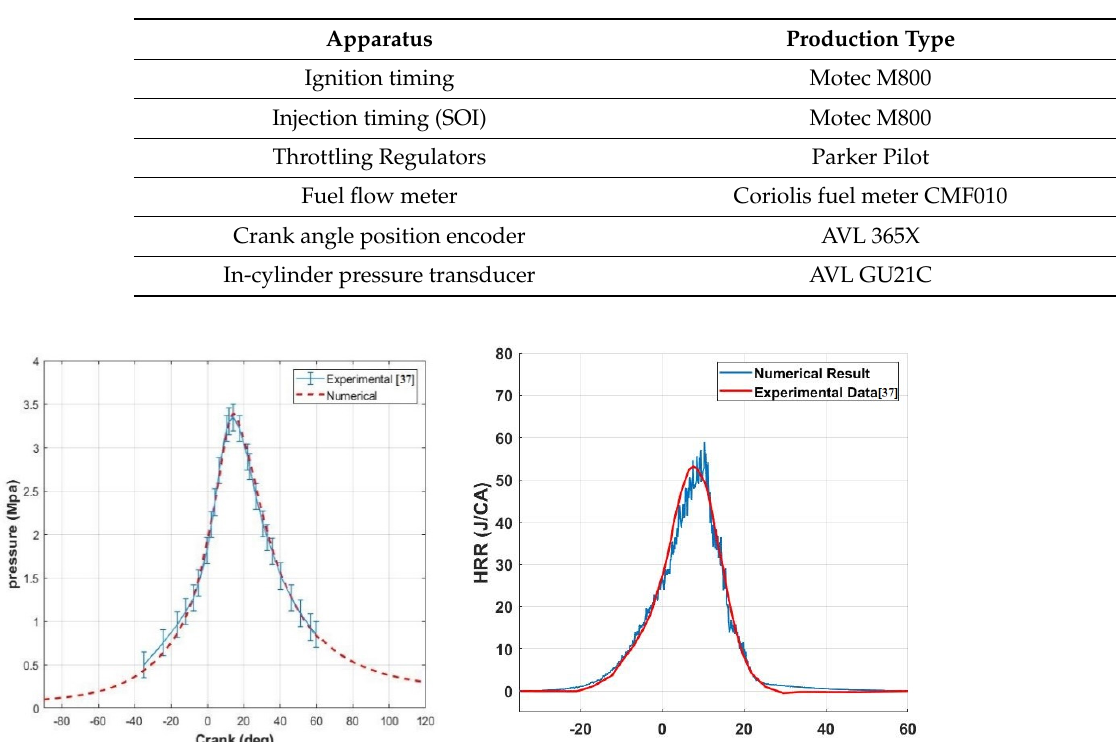
Table 5. Instrumentation apparatus for measurement. Reproduced with permission from Aghahasani, M., etc., Energy Convers Manag.; published by Elsevier, 2022 [38].